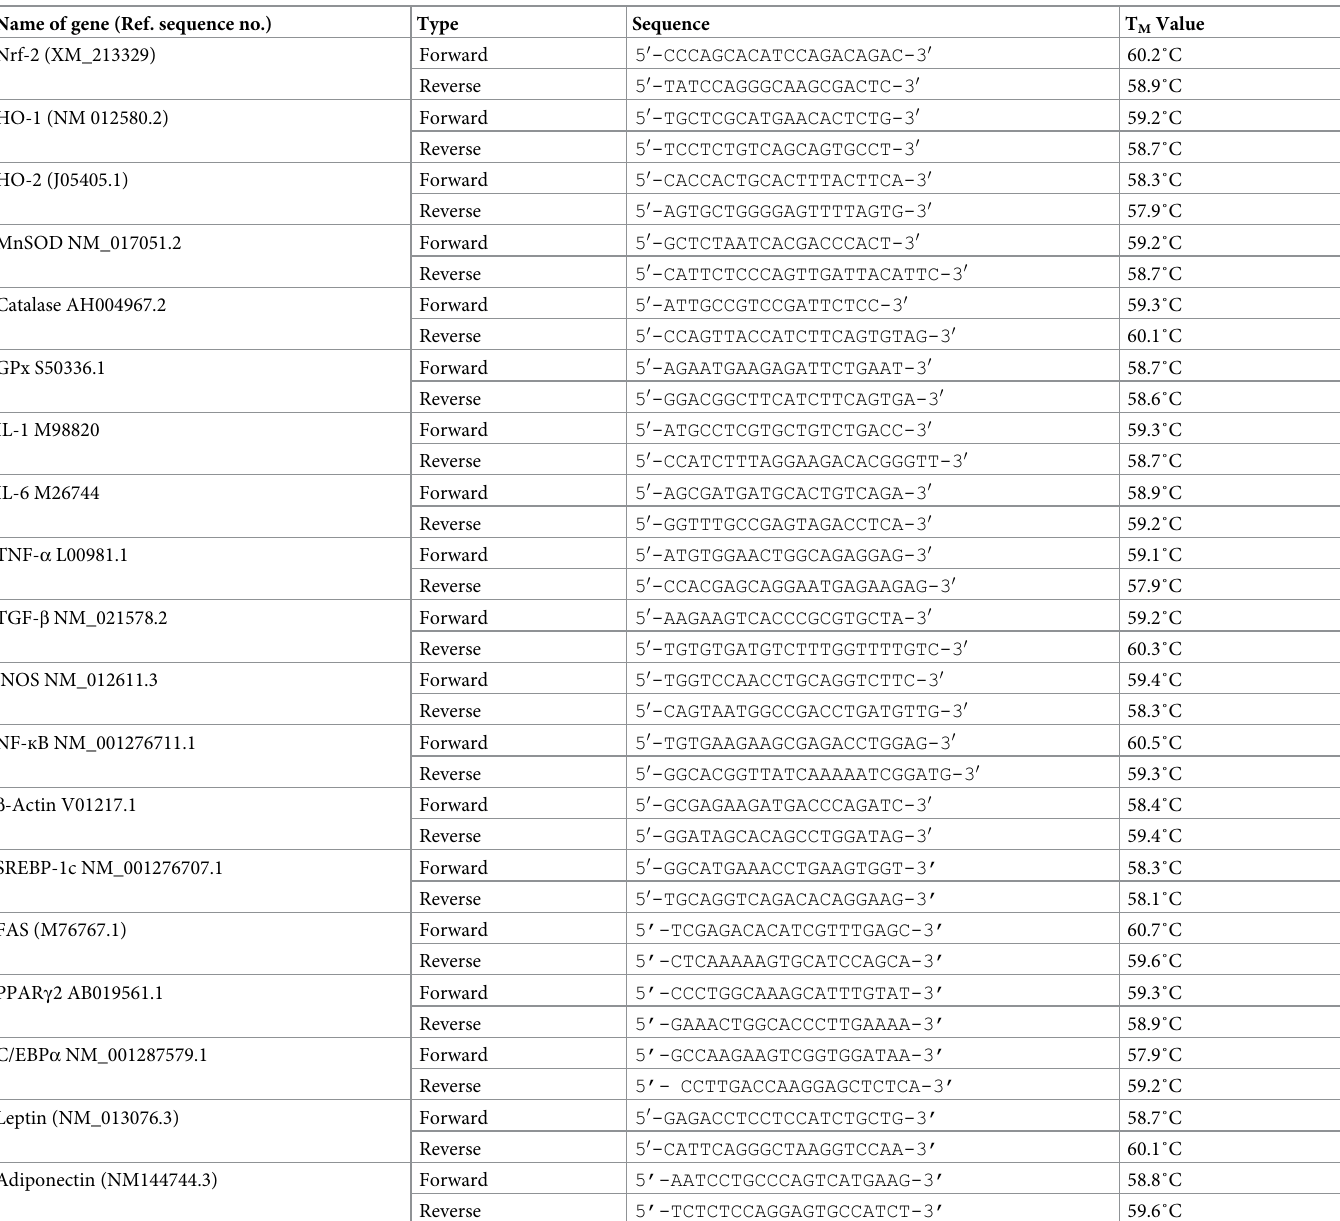
Table 1. The forward and reverse sequence of the primer used in this study. Name of gene (Ref. sequence